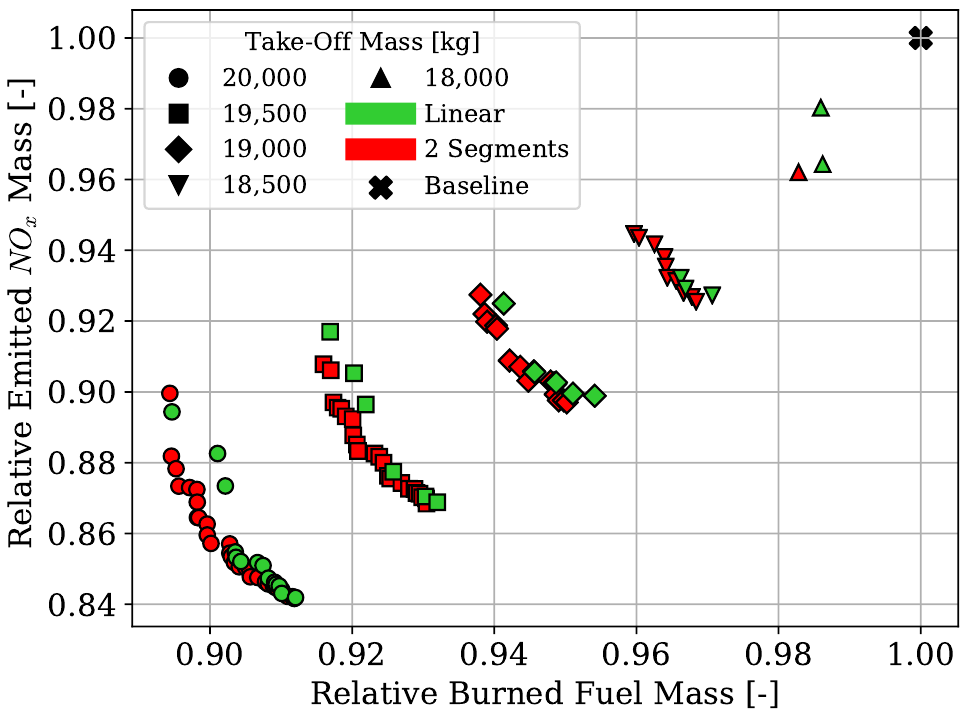
Figure 13. Pareto fronts for different Take-off Mass constraints.